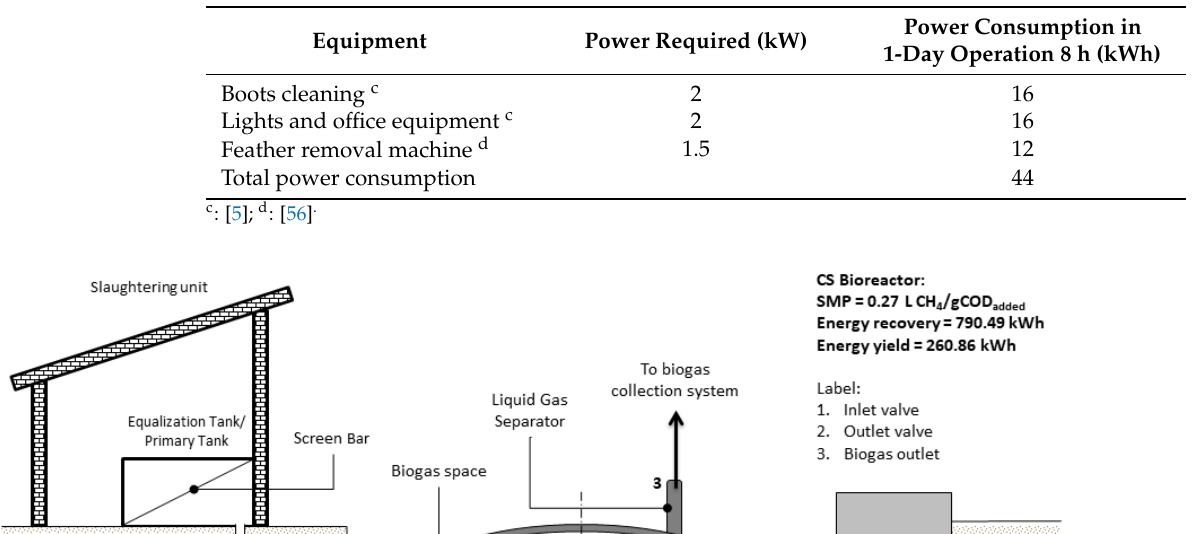
Table 5. Equipment used during slaughtering activity and power consumption.